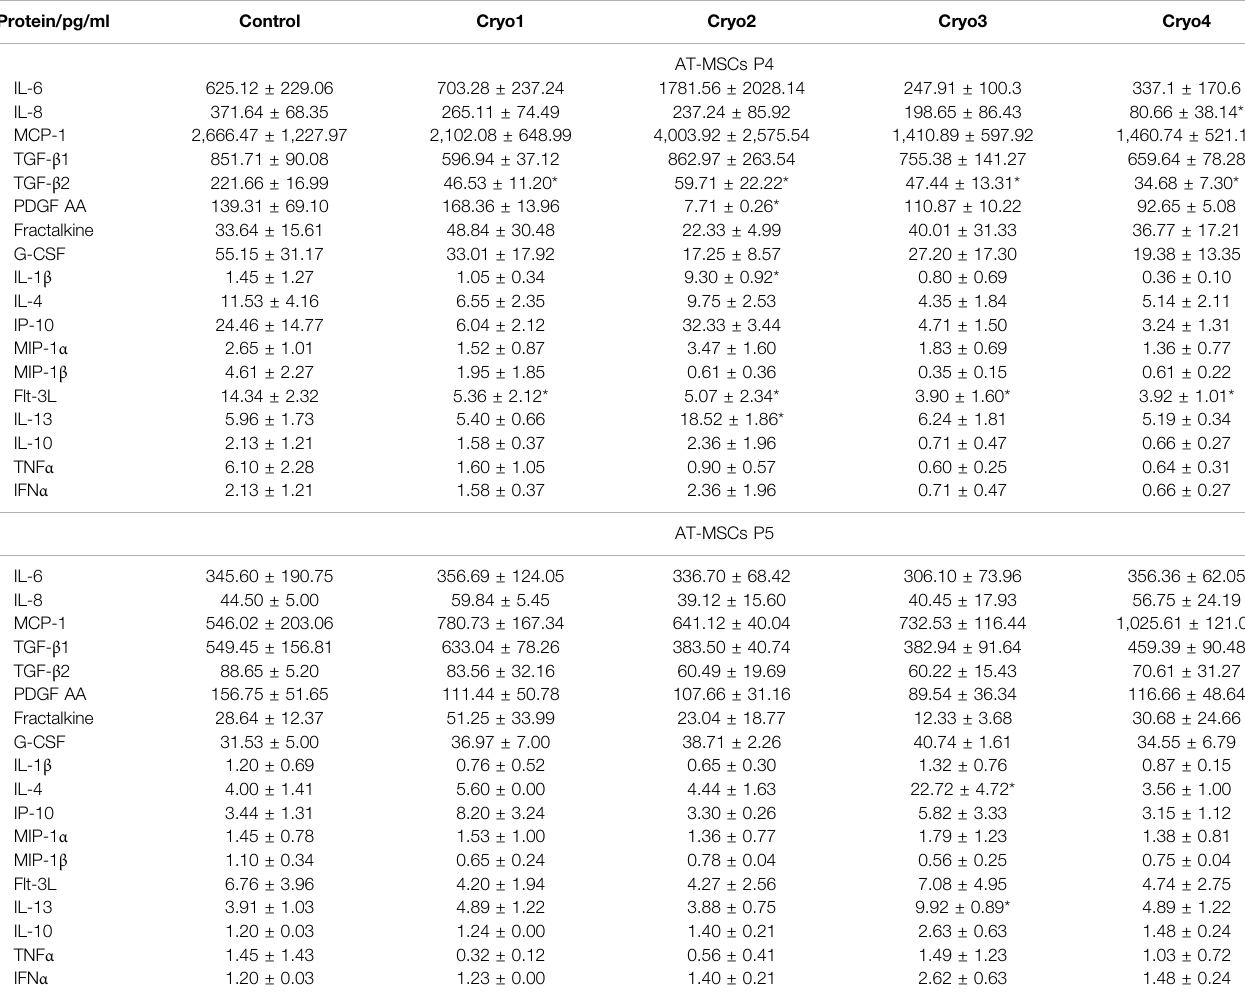
*indicates statistically signi fi cant ( p < 0.05) difference from the control